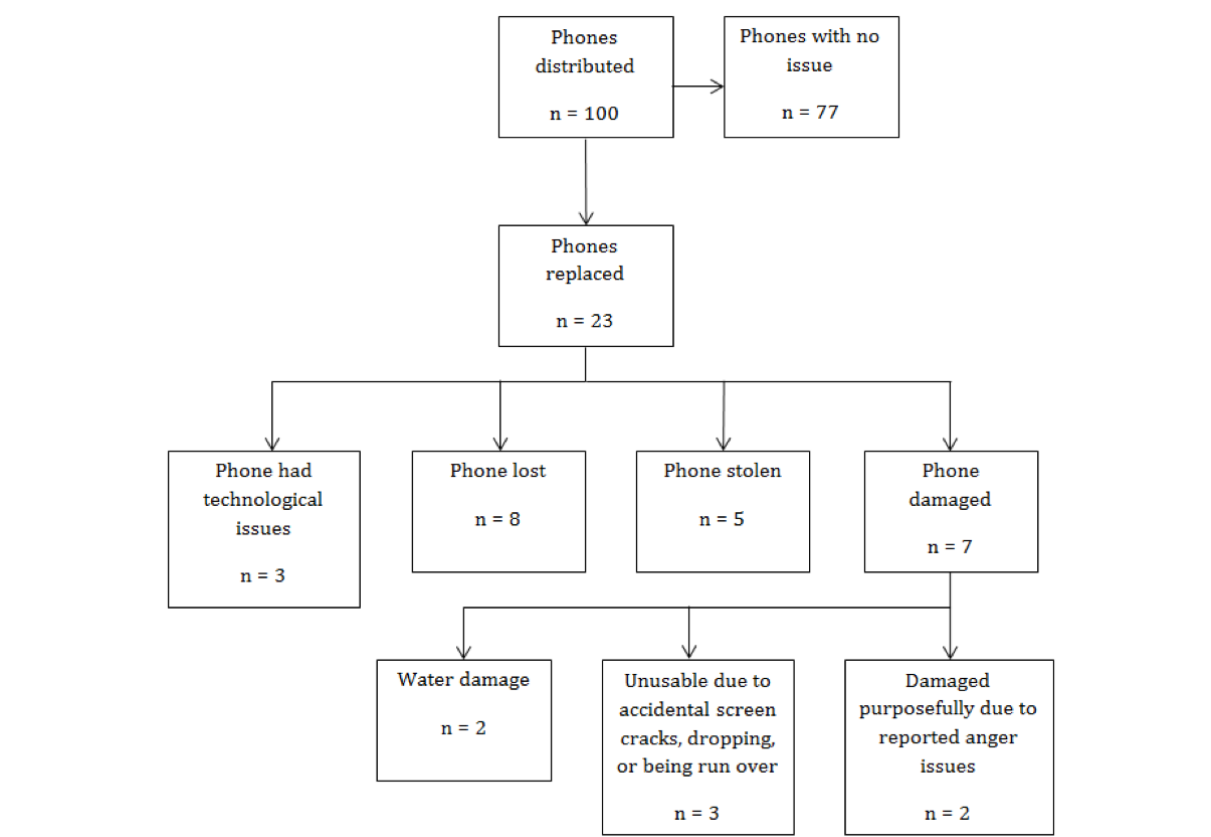
Figure 2. Phone distribution and reasons for